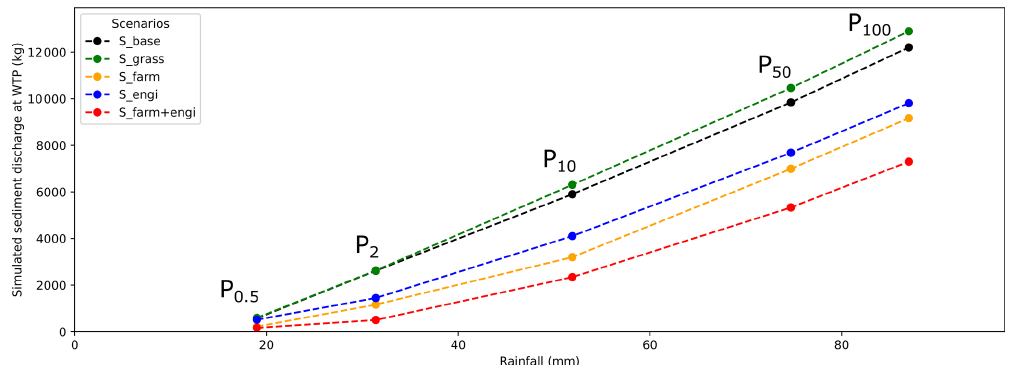
Figure 9. Simulated sediment discharge (kg) for designed storms and all scenarios at the Radicatel water treatment plant (WTP) using the DNN model (S_base: baseline scenario in 2018; S_grass: 33% of grasslands ploughed up; S_farm: + 15% infiltration capacity on 50% of the plots; S_engi: implementation of 181 fascines and 13.1ha of grass strips; S_farm + engi: combination of S_farm and